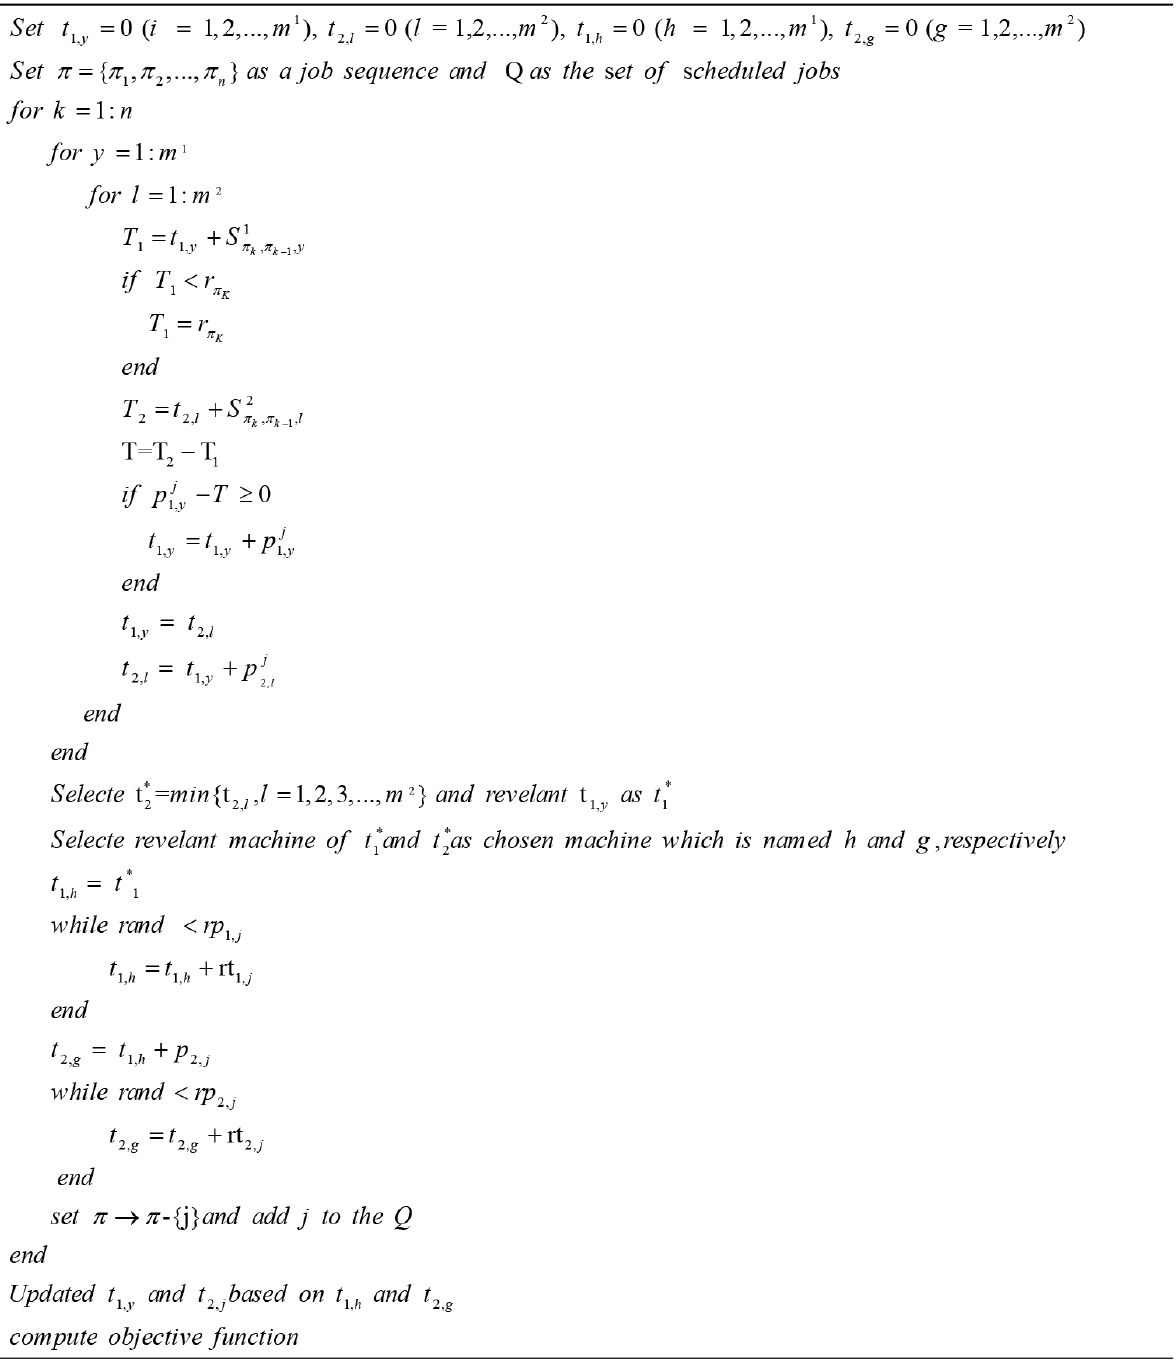
Figure 1. Simulator of fitness